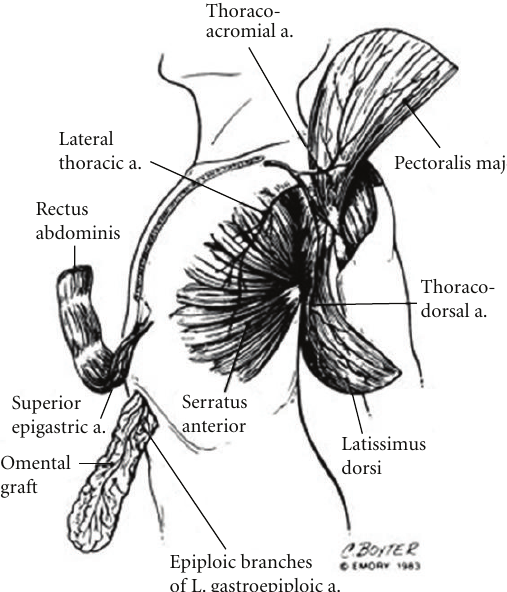
Figure 1: Anatomic drawing of the blood supply of the most used extrathoracic muscle flaps that are transposed inside the chest to obliterate infected spaces. From Miller et al.—Single-stage complete muscle flap closure of the postpneumonectomy space: a new method and possible solution to a disturbing complication, Ann Thorac Surg 1984; 38:227-31.